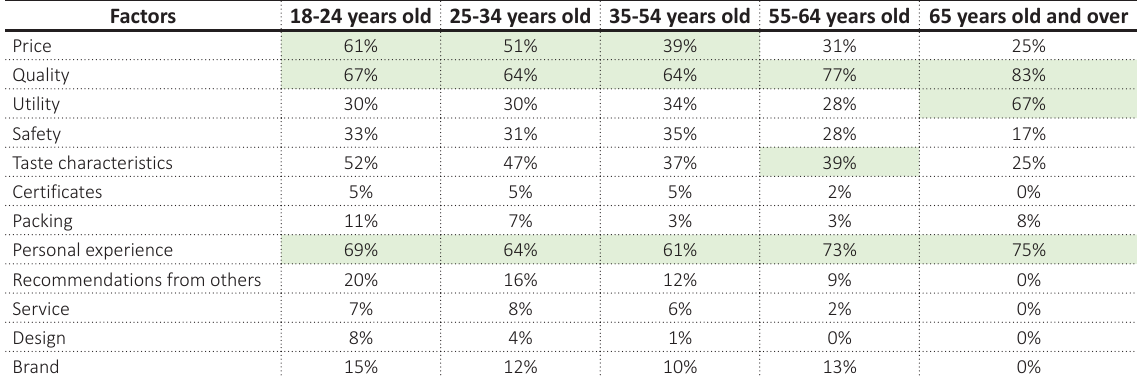
Table 3. Results to the question: Which of the following factors determines your choice when purchasing agri-food products? Choose maximum three answers. Seen in terms of age Source: Constructed by the authors based on the data of the